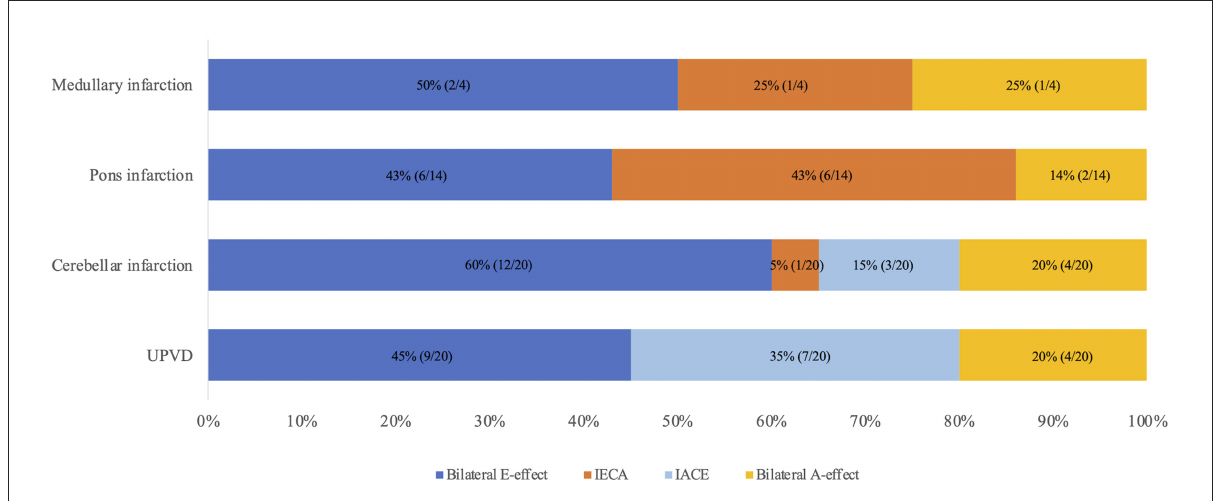
FIGURE4 The receiver operating characteristic (ROC) curve of using SD predicting brainstem damage. The area under the curve (AUC) of the receiver operating characteristic curve was 0.92 (95%CI: 0.73–1.00), with a sensitivity of 100% and a specificity of 80% when SD ≥ 3 ◦ .